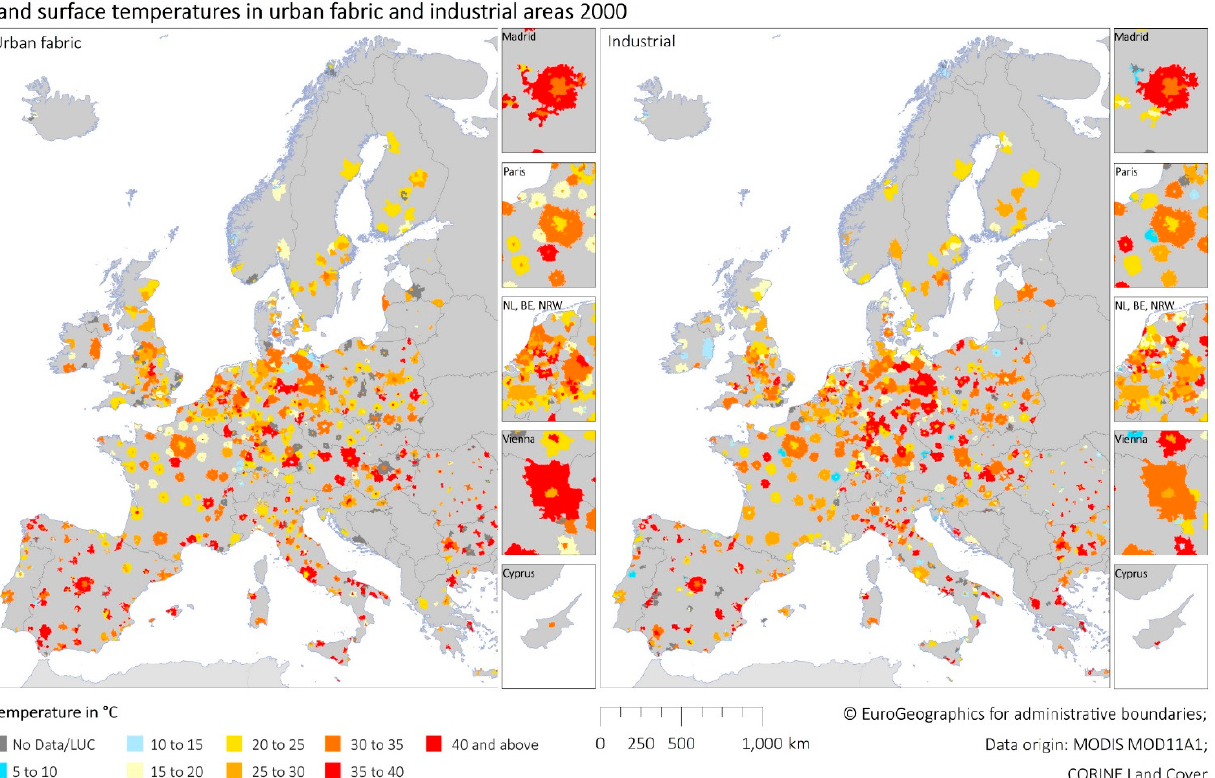
Figure 10. LST of urban fabric and industrial areas, 2000.